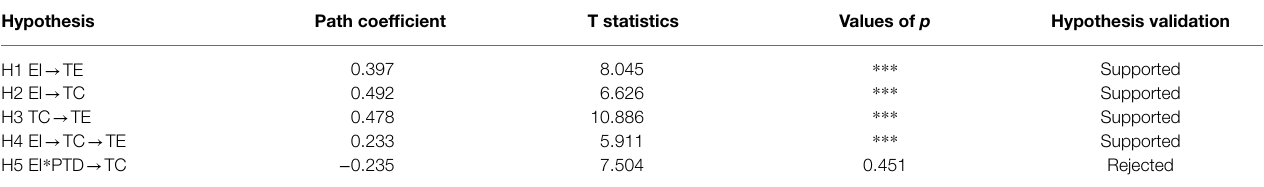
TABLE 5 | Hypotheses testing